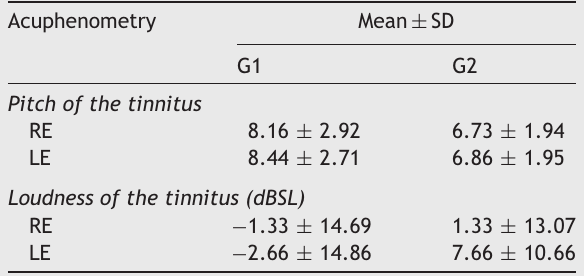
Values of mean and SD of the answers obtained in the acuphenometry in the initial